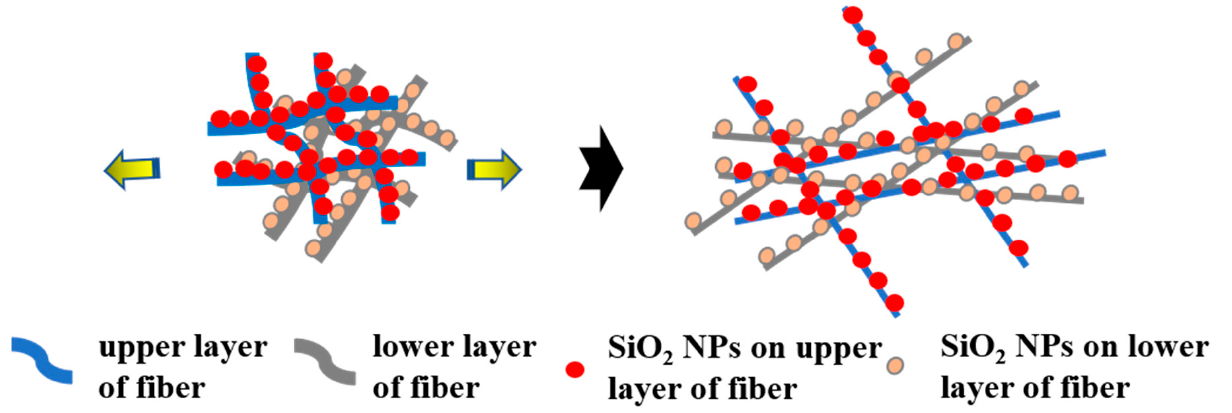
Figure 8. The schematic of the SBS/PDA/SiO 2 fibrous membrane before and after stretching.